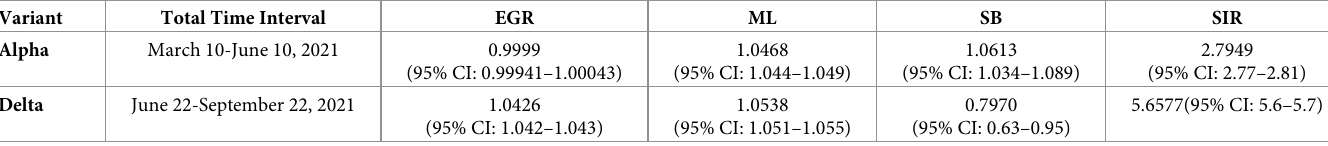
Table 6. Estimated total R 0 of Alpha and Delta variants in Iran.